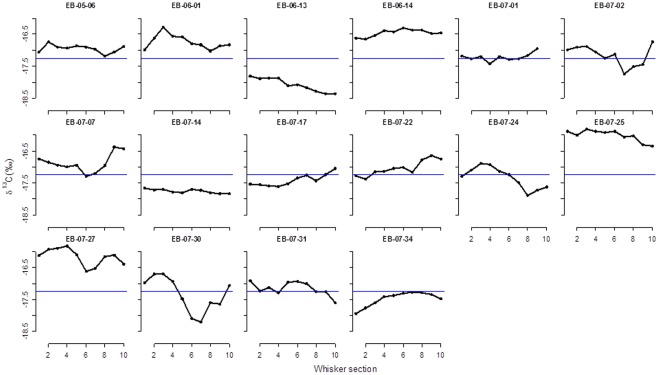
δC profiles for the 16 whiskers collected within two days of birth for bearded seals Svalbard.The segments are numbered from the basal (most recent) to the proximate (oldest). The blue horizontal line represents the overall mean δ13C from all samples.